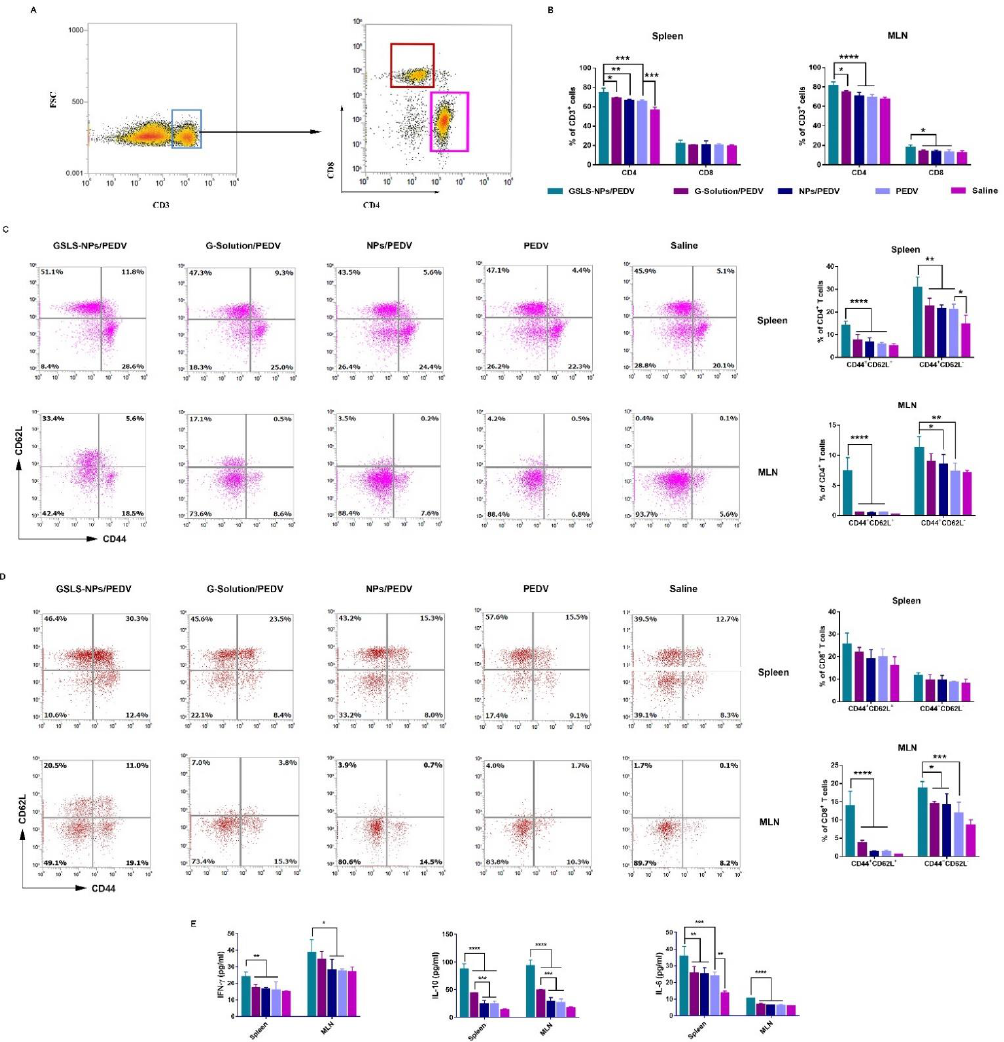
Figure 7. GSLS-NPs expanded PEDV-specific T-cell responses in the spleen and MLNs. Mice (n = 6) were gavaged and immunized as described above, and mononuclear cells were isolated from the spleen and MLNs after euthanasia on day 35. ( A , B ) Frequencies of CD4 + and CD8 + T cells. ( C , D ) Representative dot plots and percentages of memory (CD44 hi CD62L hi ) and effector (CD44 hi CD62L lo ) CD4 + /CD8 + T cells. ( E ) Cytokine production in response to re-stimulation with the PEDV antigen. Data are presented as the mean ± SD. Statistical analysis was performed using an unpaired Student’s t test. * p < 0.05, ** p < 0.01, *** p < 0 .001, **** p < 0.0001.